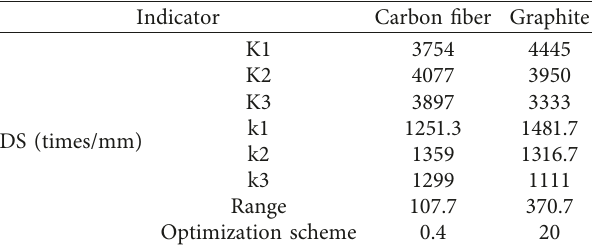
Figure 9: Rutting test results. Table 8: Range analysis of rutting test.